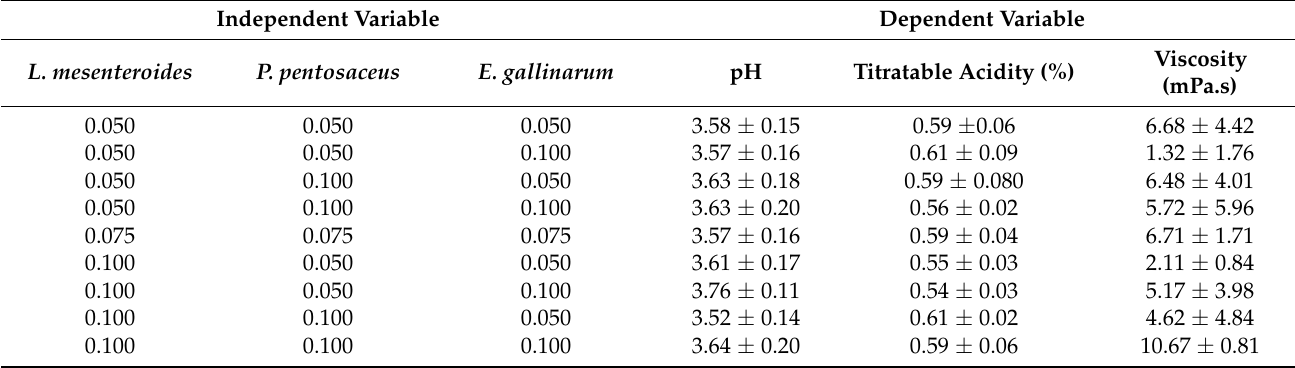
Table 6. Effect of isolated bioburen lactic acid bacteria on the pH, titratable acidity and viscosity of fermented pearl millet extract *.